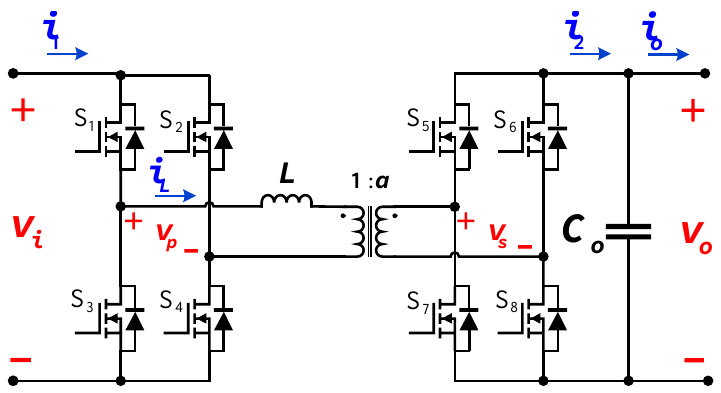
Figure 1. Circuit diagram of the dual active bridge (DAB) converter.